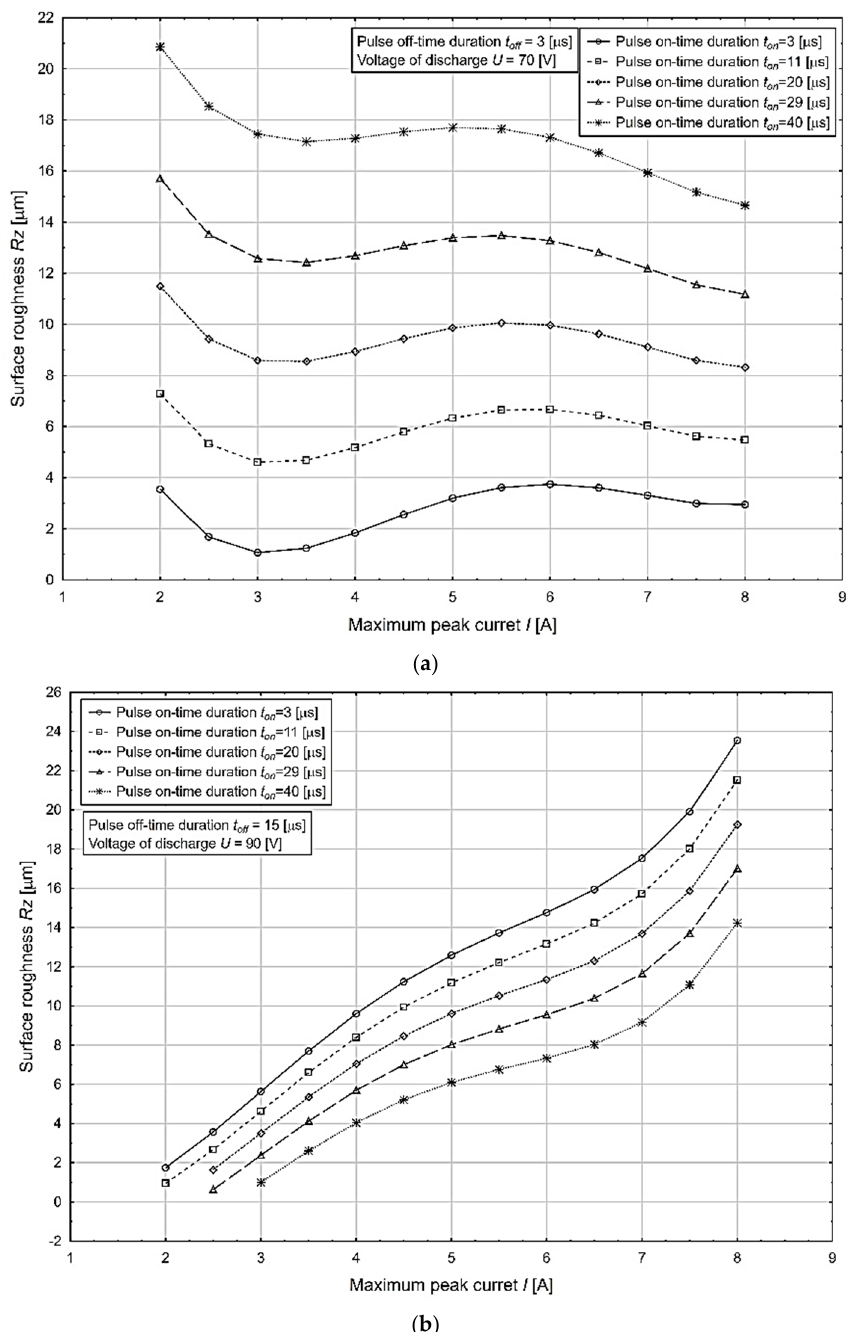
Figure 4. Dependence of the output qualitative parameter of the Rz process on the change in the value MTP of the maximum peak current I parameter at different values of t on , t off , and U . ( a ) Impact on Rz at minimum values of the parameter t off and U . ( b ) Impact on Rz at maximum values of t off and U . The above presented graphical dependencies confirmed the increasing trend of the output quality parameter of the electrical discharge process Rz depending on the increasing value of the input parameters I and t on . Its lowest value of 0.09 µ m was obtained at the combination of MTP I = 2.5 A, t on = 3 µ s, t off = 15 µ s, and U = 90 V. Conversely, its highest value of 23.50 µ m was achieved at a combination of MTP I = 8.0 A, t on = 40 µ s, t off = 3 µ s, and U = 70